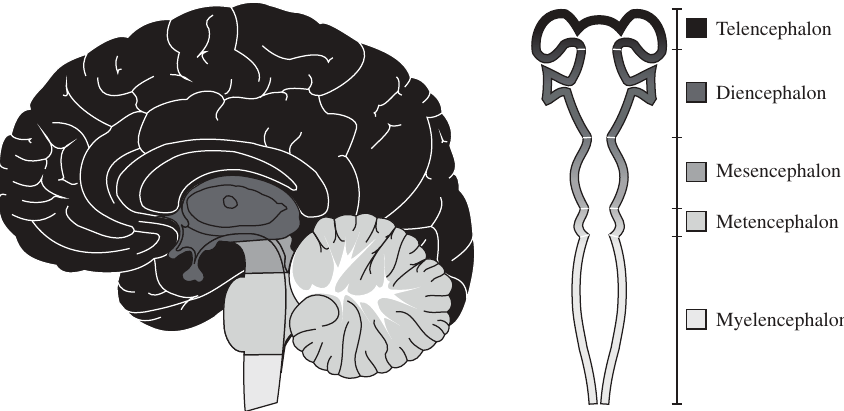
FIGURE 2: Anatomical representation of the developmental subdivisions of the